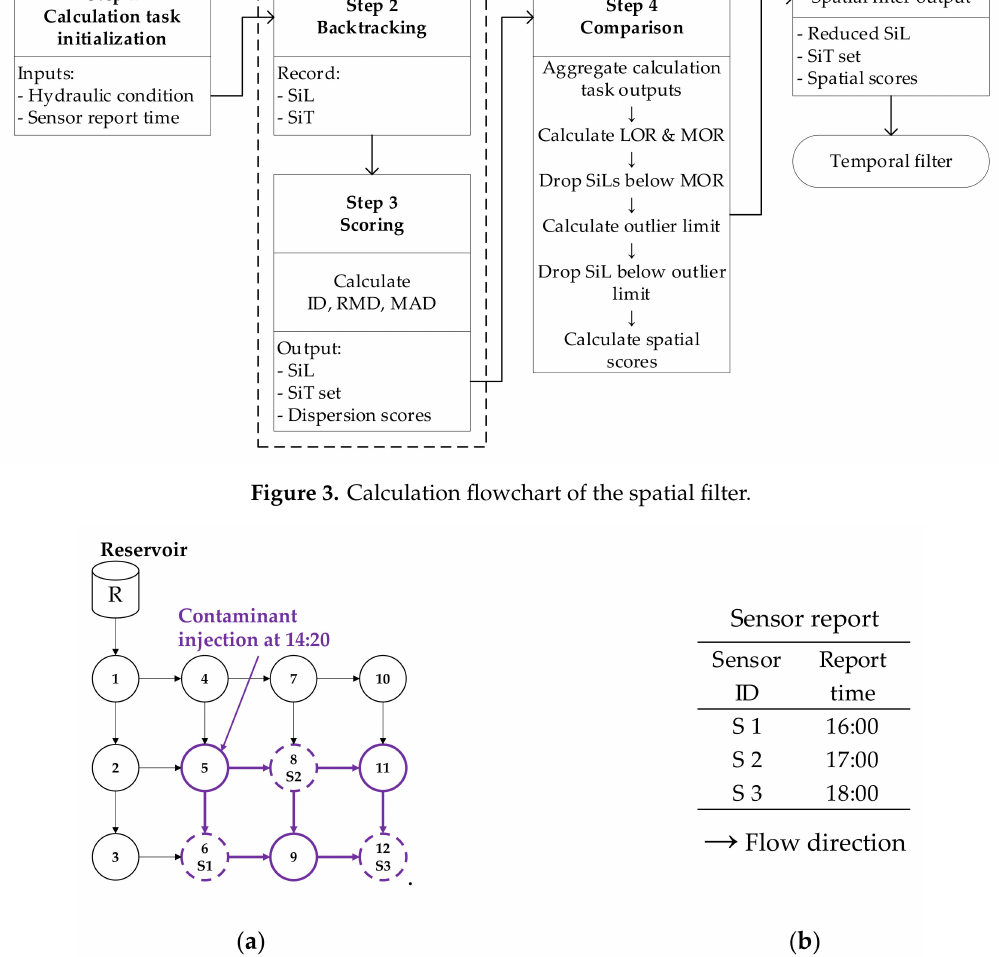
Figure 4. Sample data for illustration: ( a ) Sample water distribution network (WDN) and ( b ) Sensor report